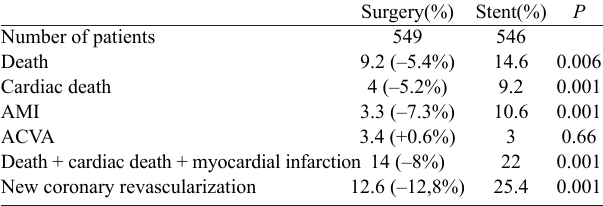
Total mortality Acute myocardial infarction Stent occlusion/thrombosis ACVA